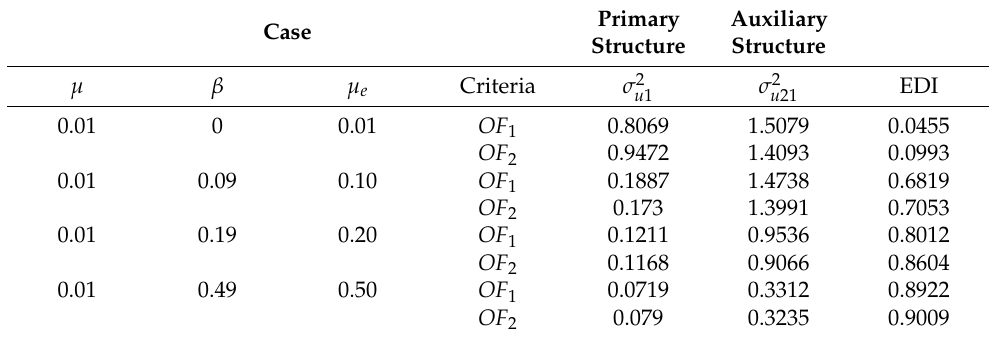
Table 2. Primary and auxiliary variance and EDI value for various values of parameter β